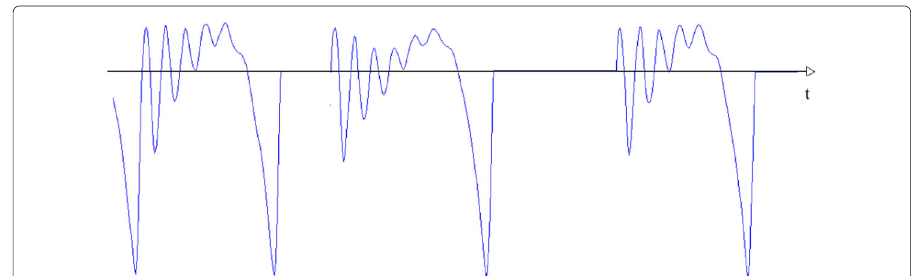
Fig. 12 Example of the signal in the time domain obtained by the proposed voice generation